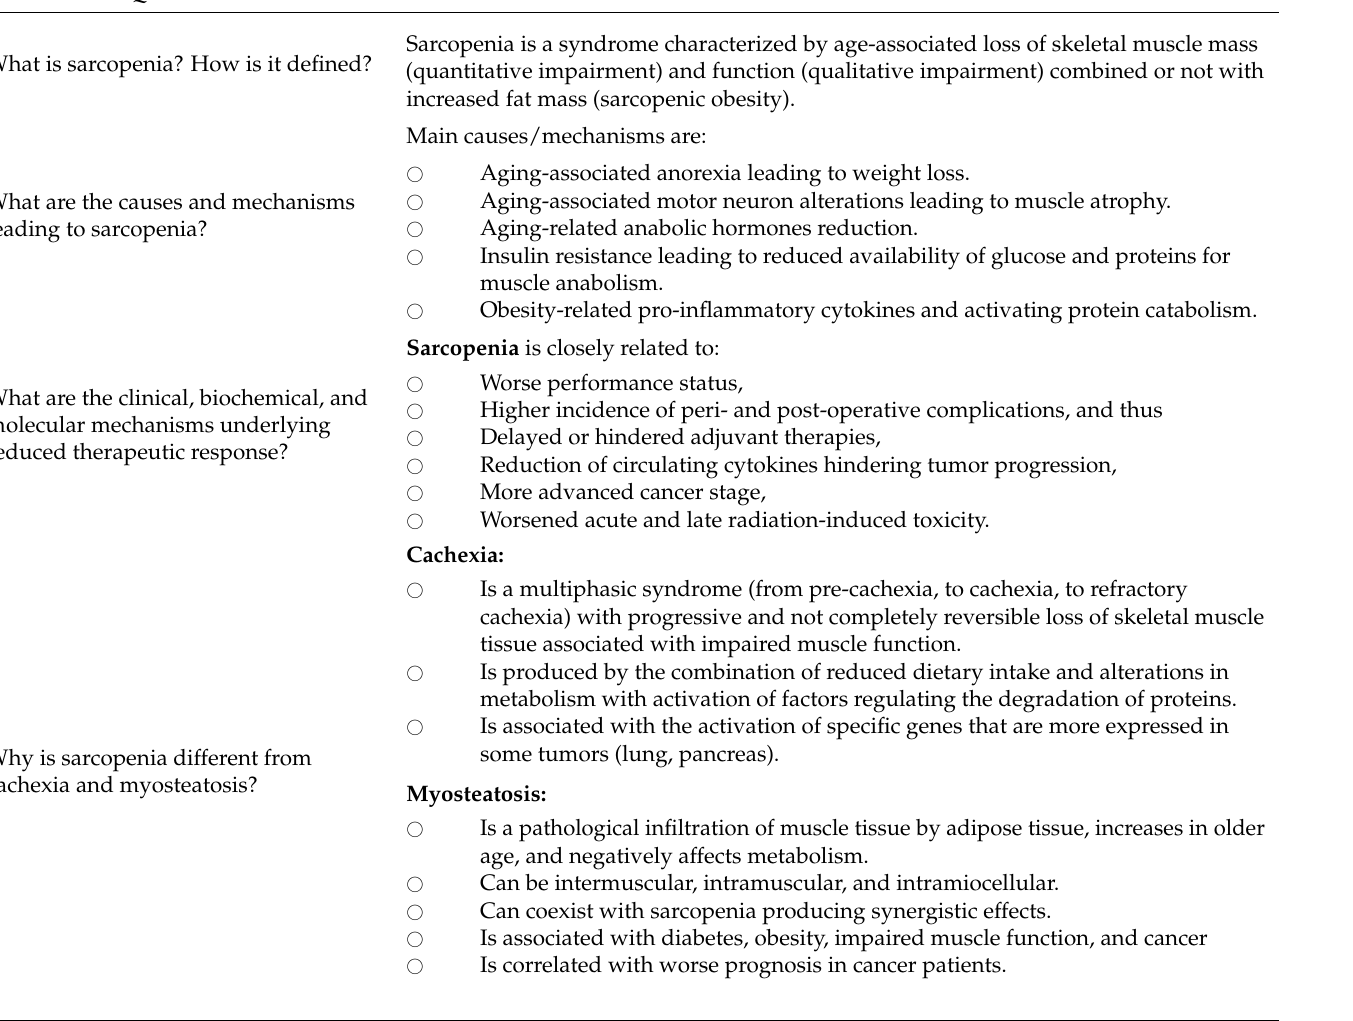
Table 3. Summary of questions and